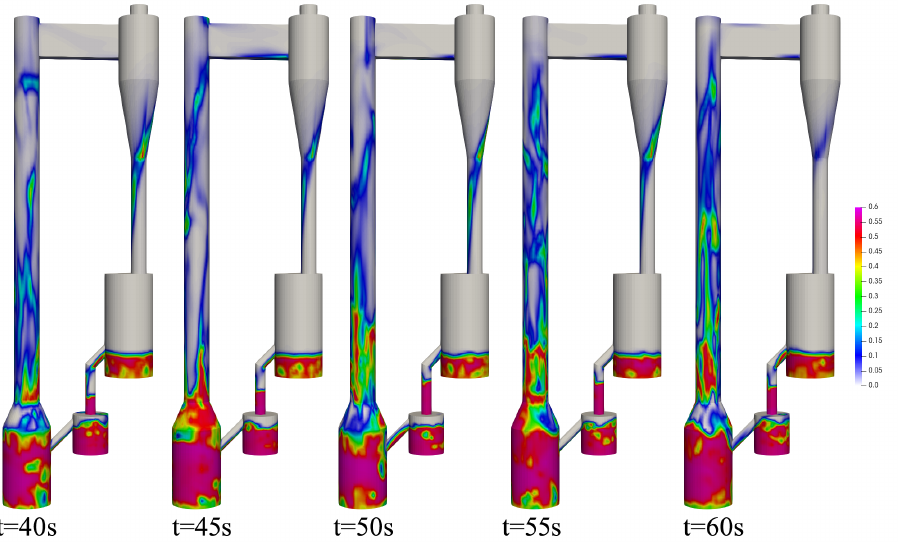
Figure 5. Instantaneous solid volume fraction at different time. The time-averaged relative pressure for reference case is shown in Figure 6. The pressure value corresponds to the solid mass above the measurement point. Relative pressure decreases with the height of the reactor. The gradient of pressure at the bottom bottom of reactor, and it operates more similarly to a bubbling fluidized bed. In the riser,